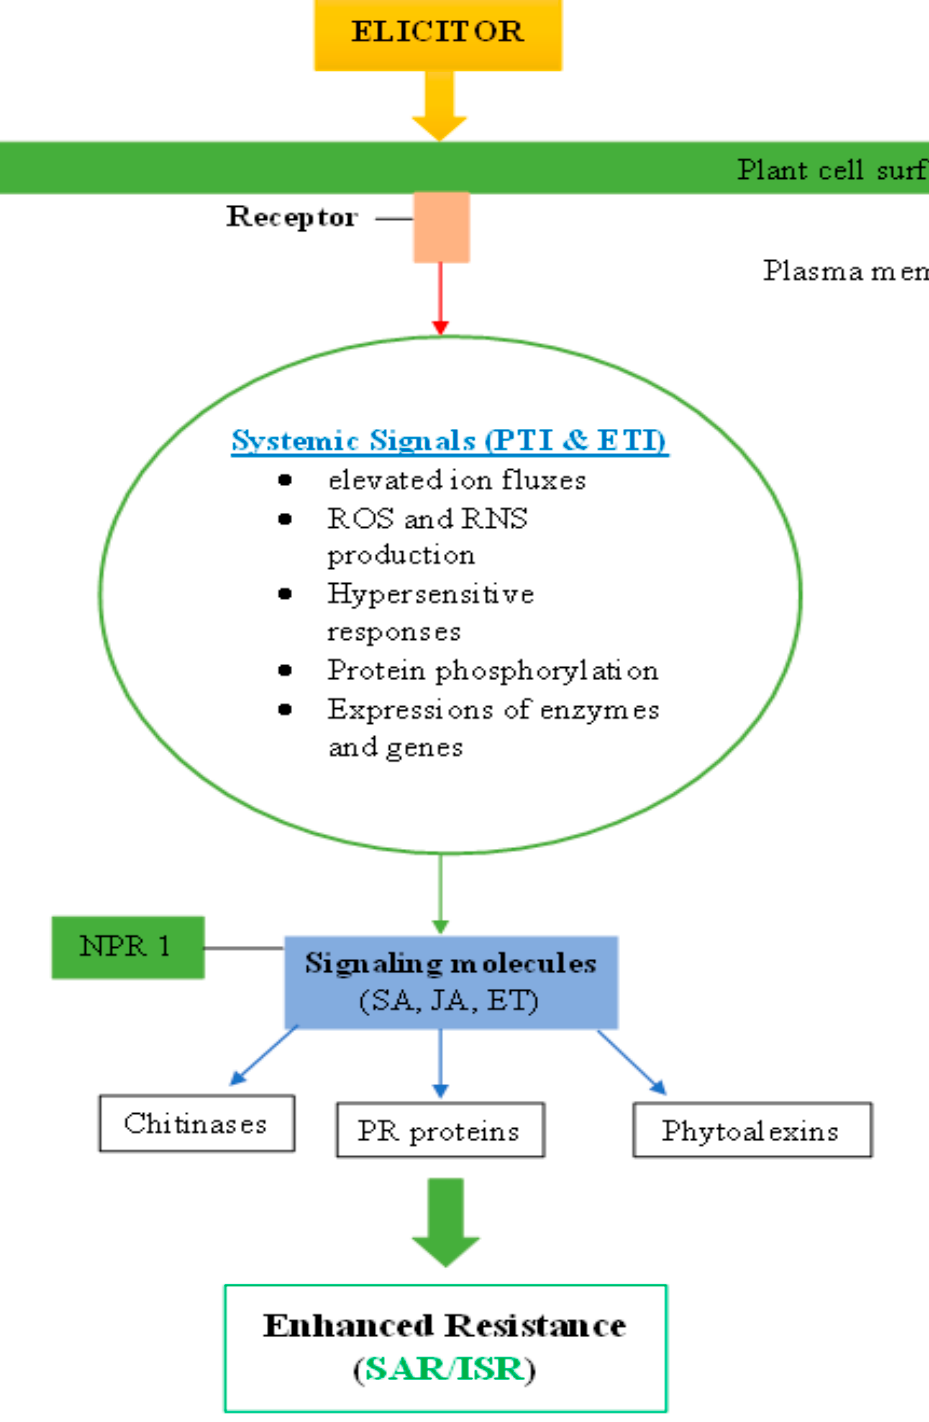
Figure 2. General mechanisms of plant responses to elicitors.